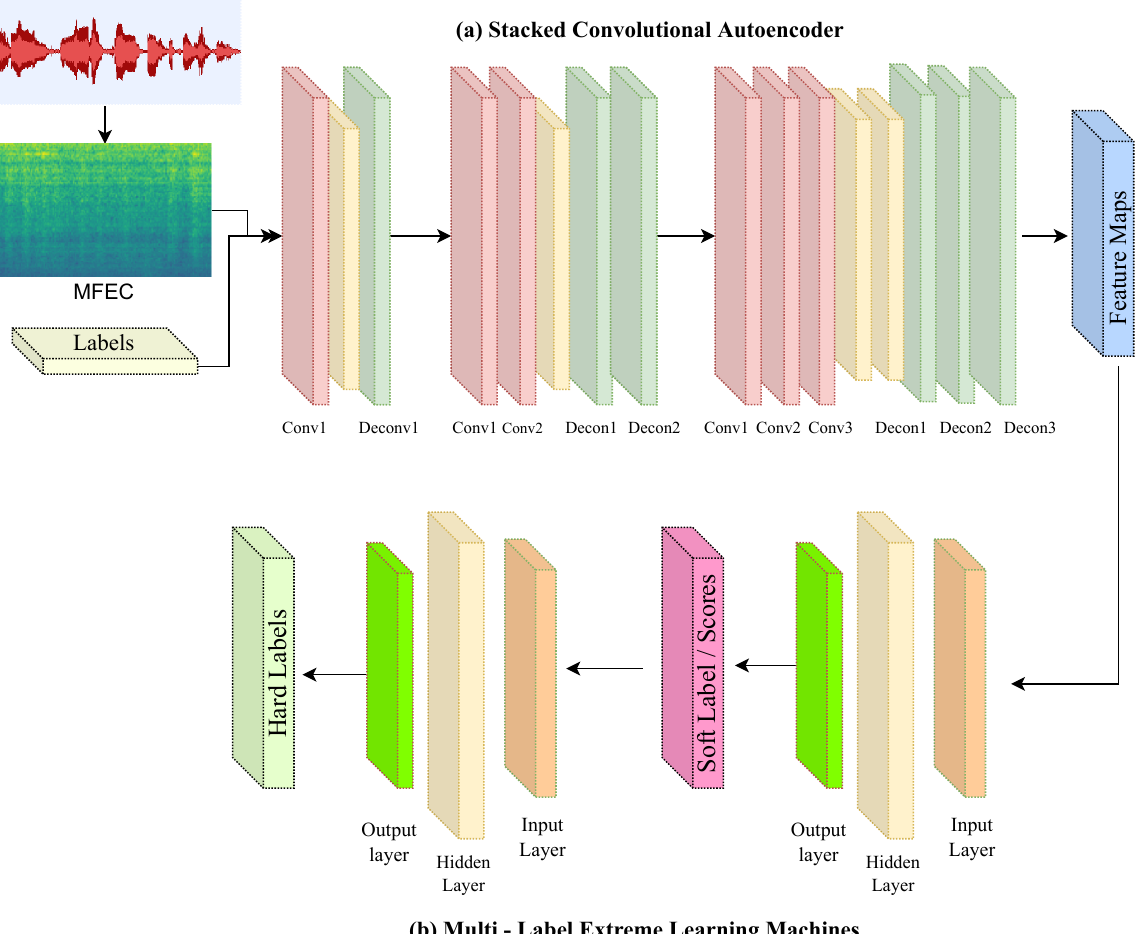
Figure 2. The architecture of Proposed Method consists of two parts. ( a ) SCAE ( b ) MLELMs. In the encoder section, convolutional layers with ReLU activation functions are fol- lowed by max pooling layers. In the encoder part, nonlinear transforms are used to map the input vector to the hidden representation. Next, the reverse transform is reconstructed from the hidden representation to the original audio input signal in the decoded